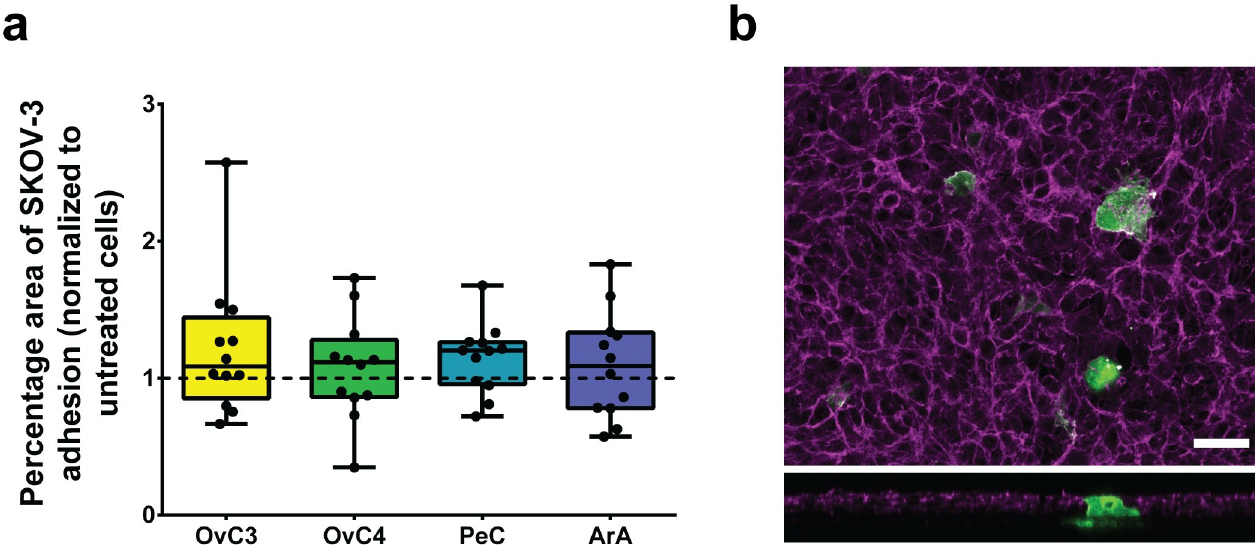
Fig 5. SKOV-3 cell adhesion on exposed MeT-5A cells compared to untreated cells. a) Percentage area of SKOV-3 cell adhesion on mesothelial cells when normalized to untreated cells (dotted line); data are presented as median ± Min/Max, n = 2. b) SKOV-3 cell (green) adhesion on and through the MeT-5A cell layer (magenta, exposed to OvC4), scale bar is 50 μ